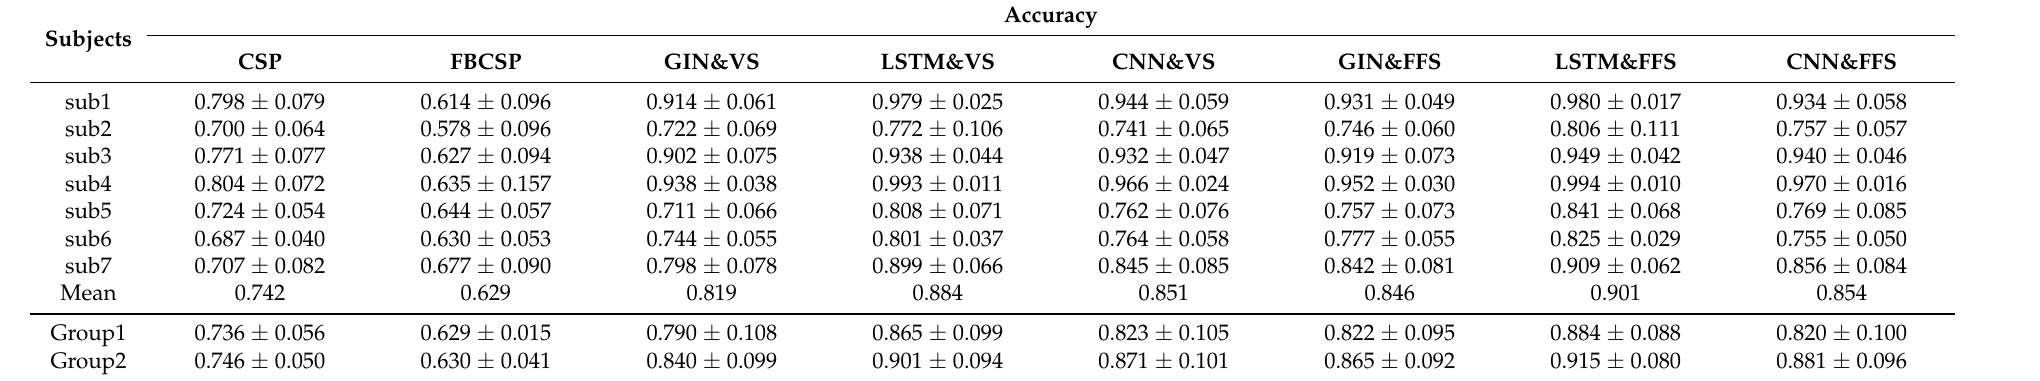
Table 2. The overall comparison results of average classification